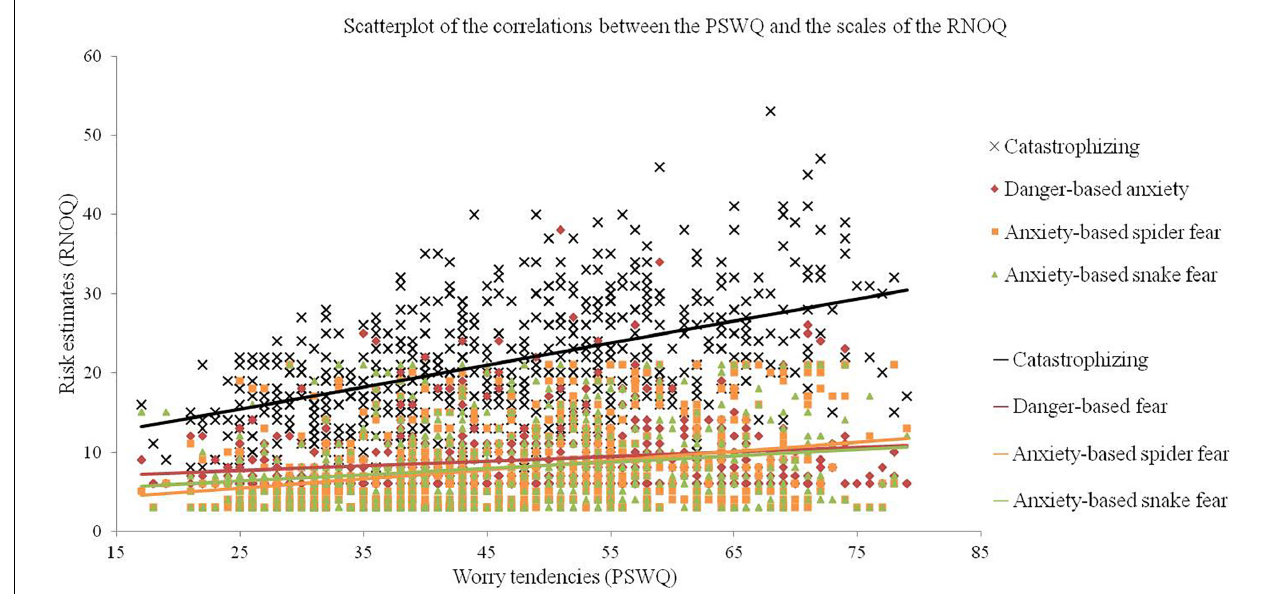
FIGURE 1 | Relationships between worry tendencies (PSWQ) and risk estimates (scales of the RNOQ). The lines mark the linear trend of the relationships.